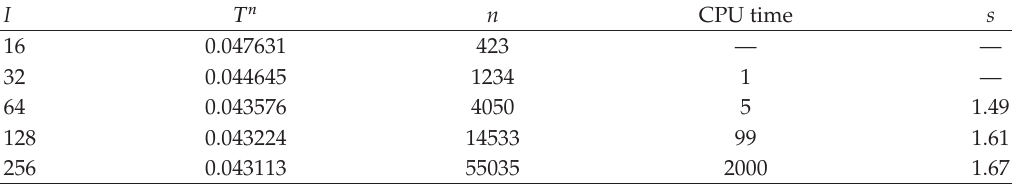
Table 2: Numerical blow-up times, numbers of iterations, CPU times (cid:3) seconds (cid:4) and orders of the approximations obtained with the implicit Euler method defined in (cid:3) 10.2 (cid:4) .